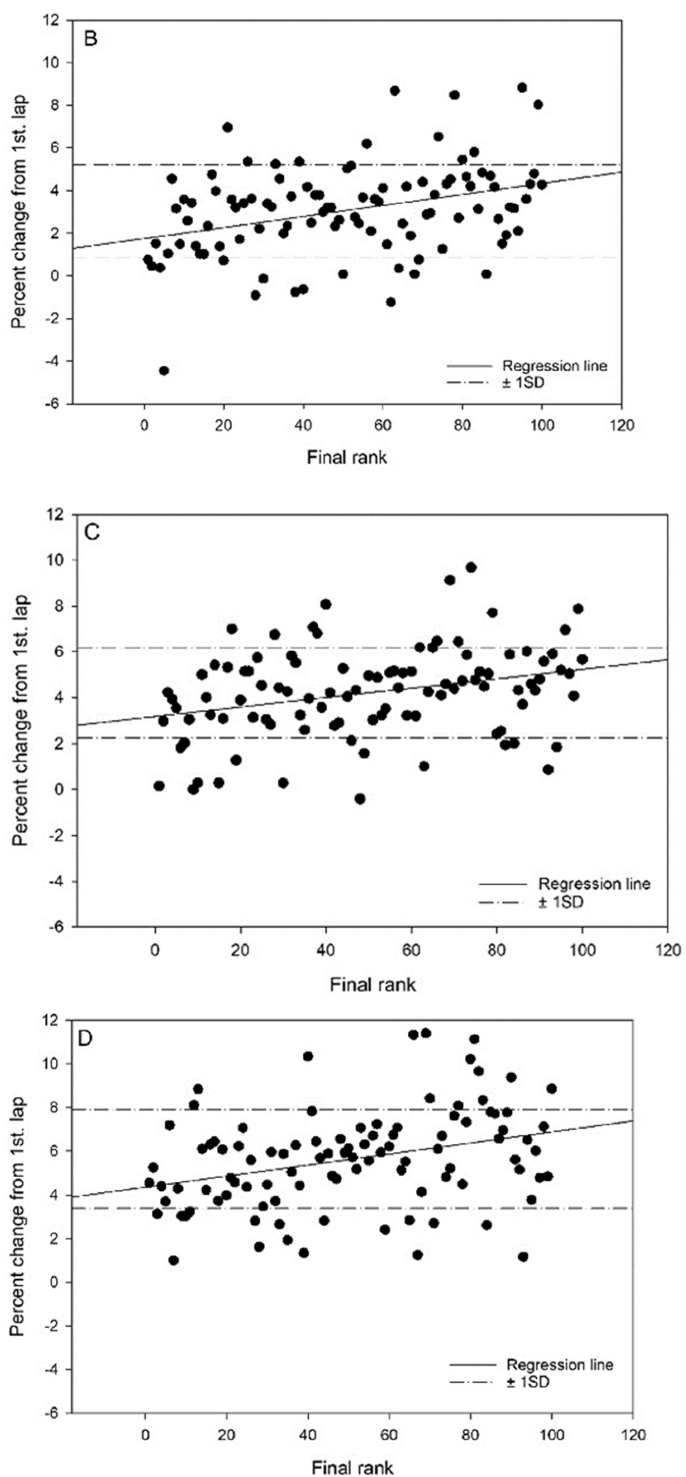
Figure 1. The individual speed changes between 1st versus 2nd and 3rd laps for the 100 best in the final rank in four different cross-country competitions: ( A ) classical, year 1; ( B ) freestyle, year 1; ( C ) classical, year 2; ( D ) freestyle, year 2. Percentage speed changes are calculated as percentage increase/decrease in lap time for an average of the 2nd and 3rd lap, compared to that of the 1st lap. Solid lines represent regression lines, and dash-dot lines represent one standard deviation of the mean percentage change.